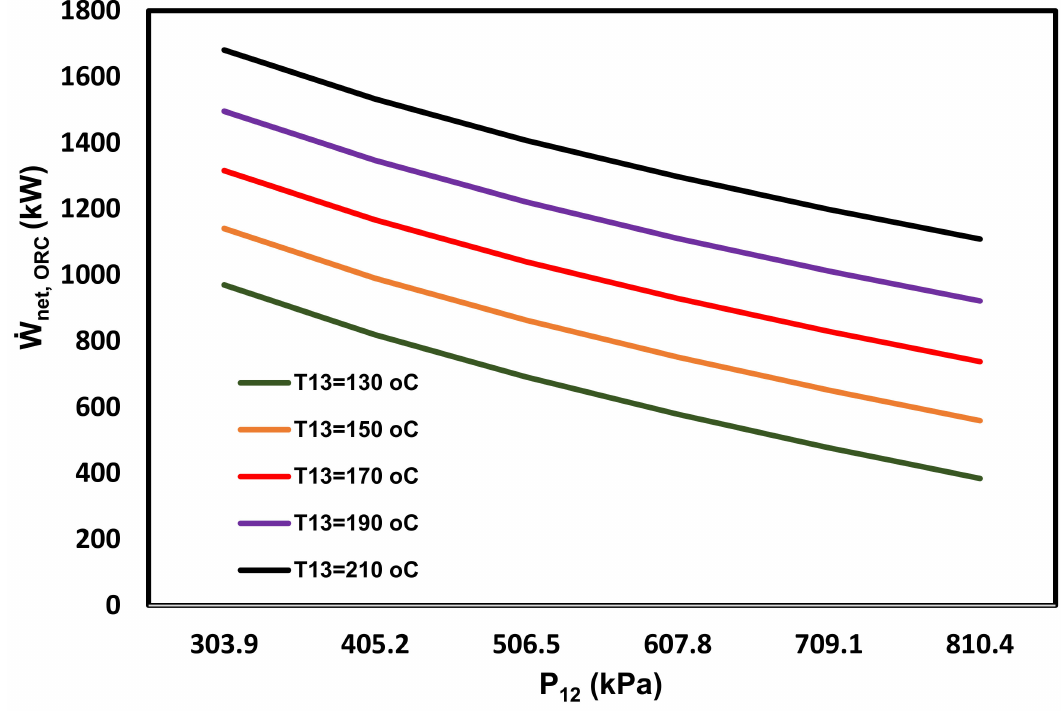
Figure 9. The variation in net output power of the ORC with pump outlet pressure at different inlet turbine